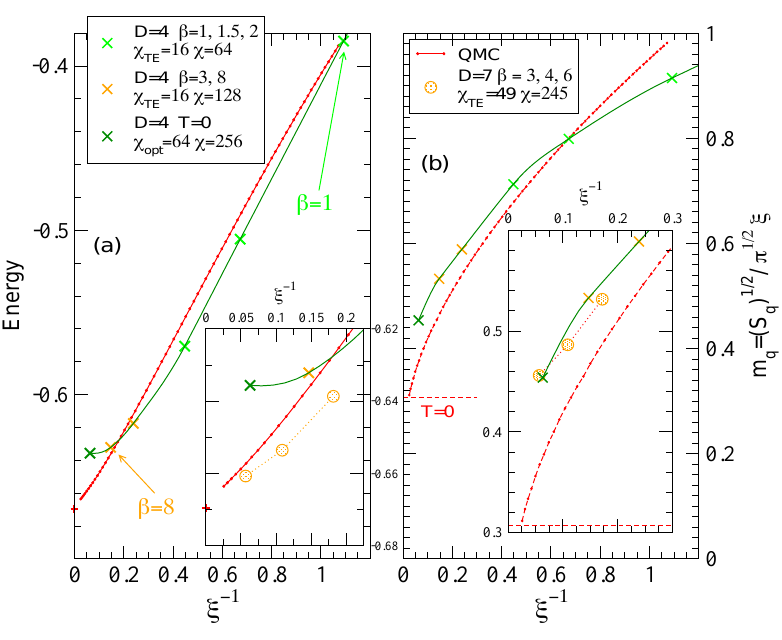
Figure 7: Energy (a) and magnetization estimator m (b) plotted versus the inverse q = D 2 . Large of the spin correlation length, for D = 4 tensors optimized with χ TE enough environment dimensions χ are chosen to get converged results (in contrast to results obtained with χ = χ , also shown). End-points obtained directly at T = 0 TE (see text) are also included. QMC results in the thermodynamic limit are shown in the range β ∈ [ 1,4 ] , for comparison, as well as the T = 0 magnetization [ 4 ] (horizontal dashed line in (b)). Similar results for D = 7 are also shown as circles in the inset of panel (a) and in panel